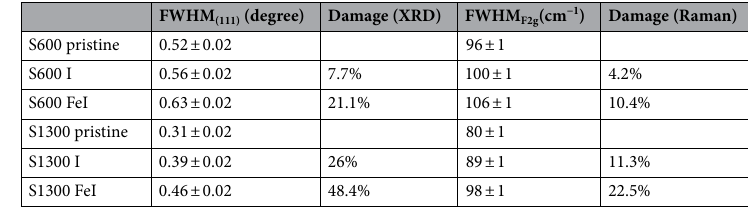
Table 1. FWHM of (111) XRD peak, FWHM of F 2g Raman band and the damage as calculated from XRD and Raman spectroscopy for all samples. FeI denotes the simultaneous irradiations, I denotes the single beam (i.e., only I)